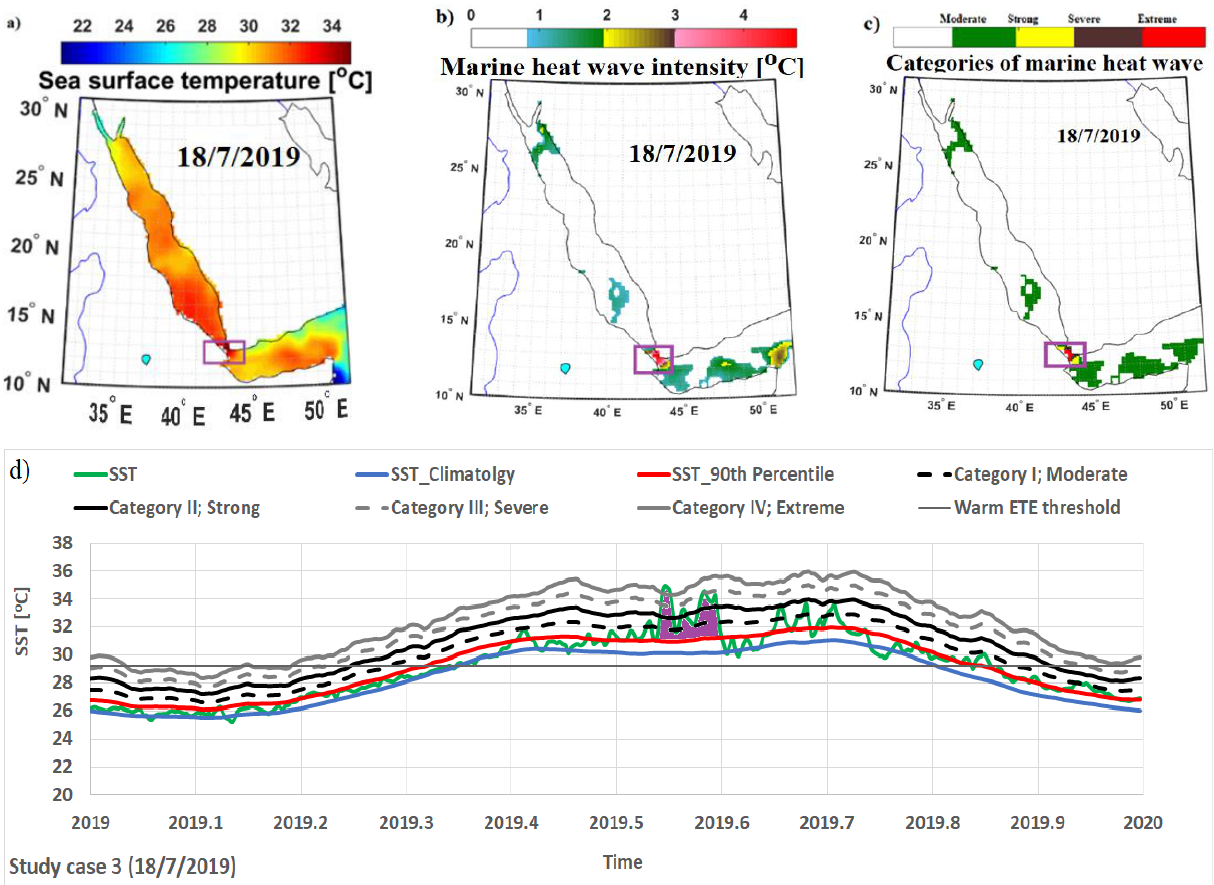
Figure 15. Representative of the MHW event (study case 3) showing the sea surface temperature ( a ), intensity [°C] of marine heat wave event ( b ) and category of that event ( c ) at the peak of the event and the time series during the event’s year ( d ), spatially averaged over an area around the maximum intensity grid, which is shown in bubbles.